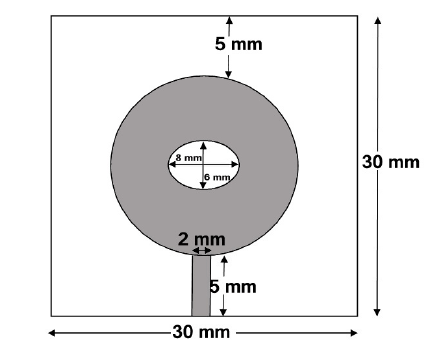
braic polynomials.